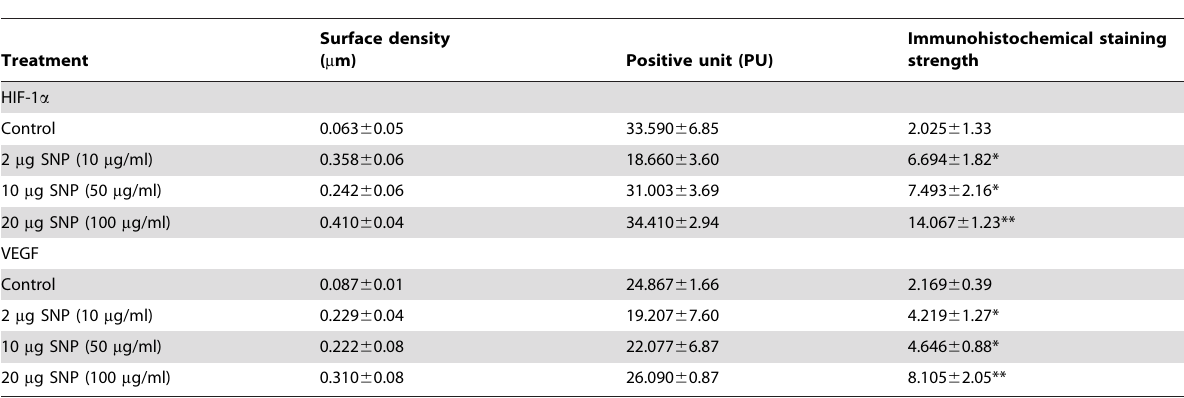
Table 3. SNP-induced overexpression of HIF-1 a and VEGF in the SNP-injected hypoderm of mice ( n =3).